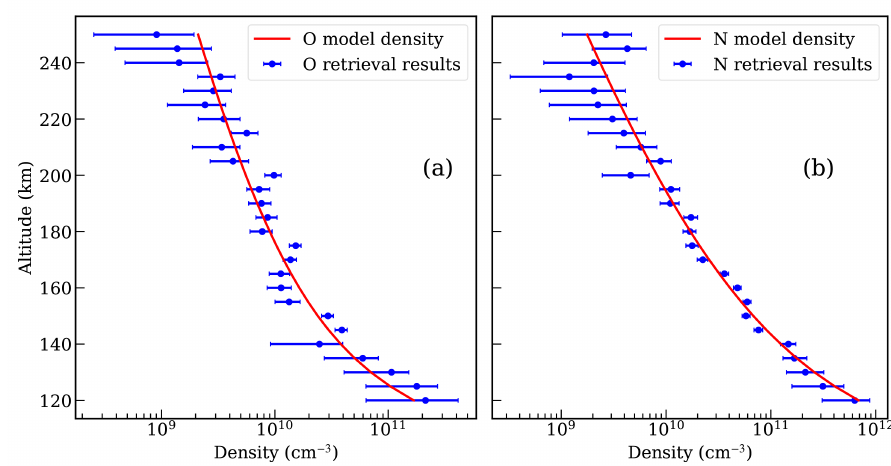
Figure 4. Comparison between the retrieved results of elements O and N and NRLMSISE-00 model values. The blue dots with error bars represent the retrieved result of O element, and the solid red line represents the model value of O element in Panel ( a ). Panel ( b ) is the same as Panel ( a ) but for the N